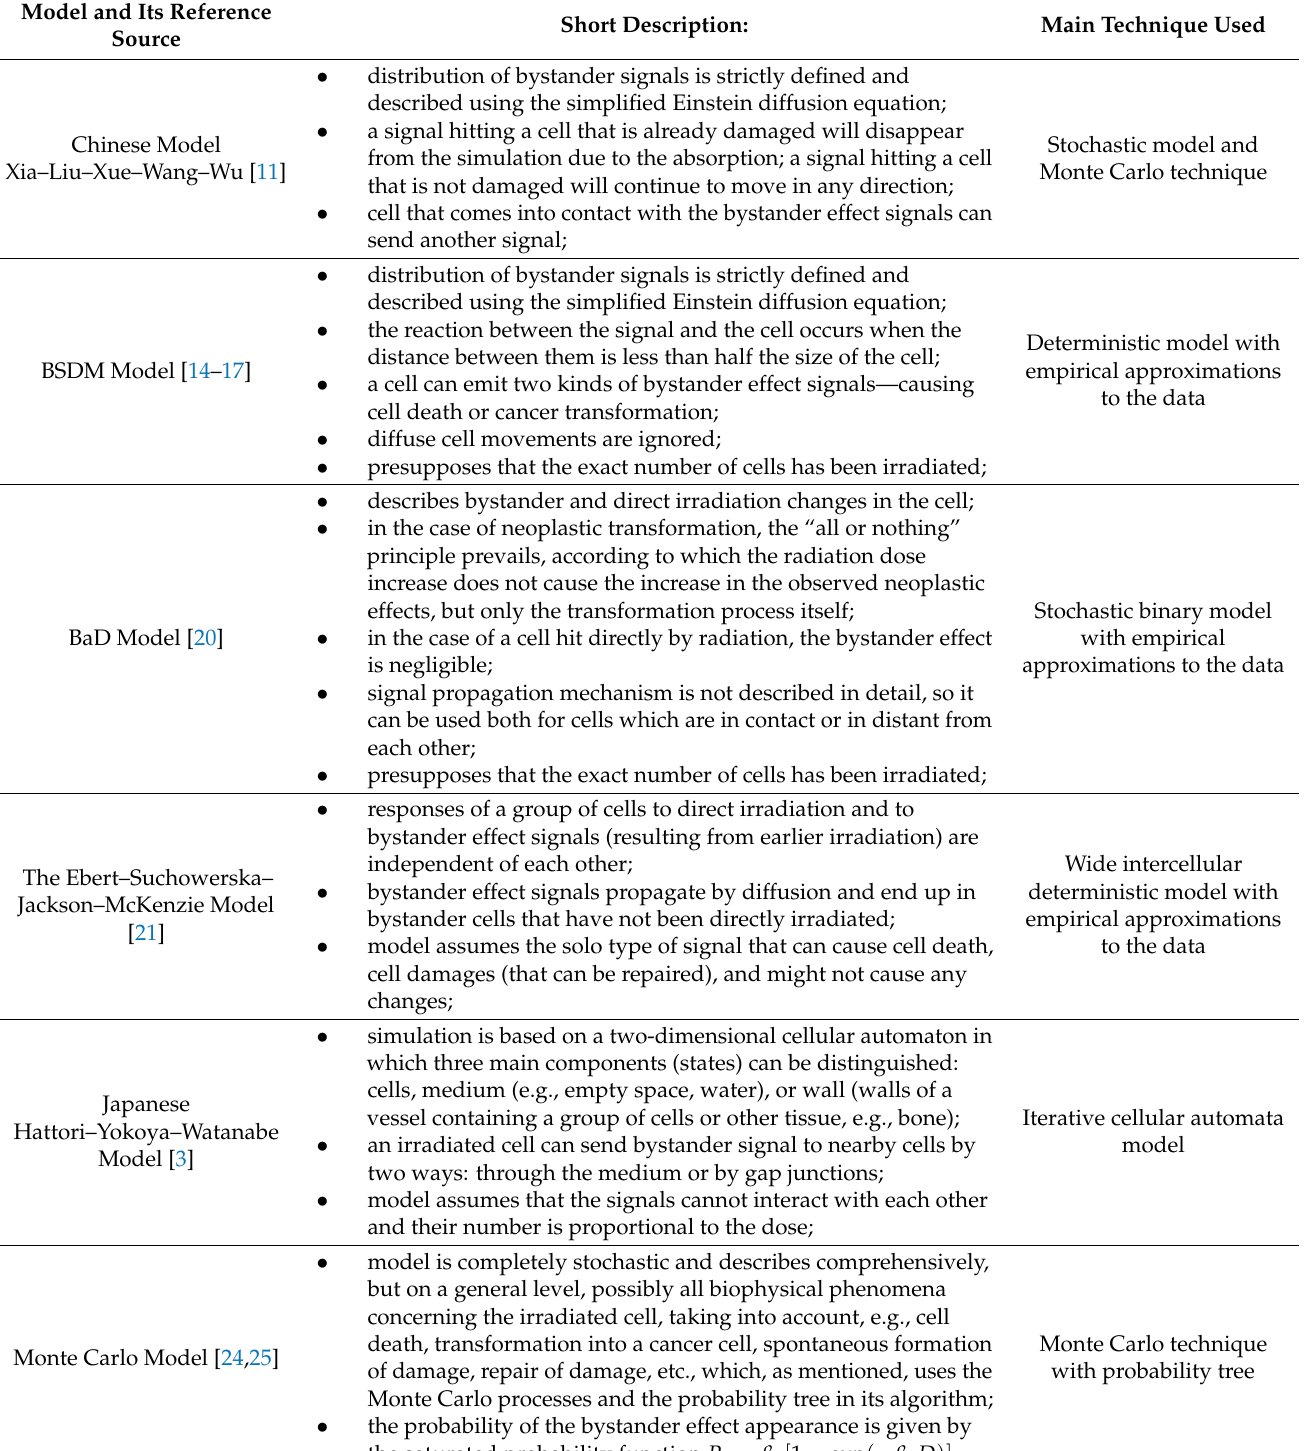
Table 5. The comparison of bystander effect computational models described in Section